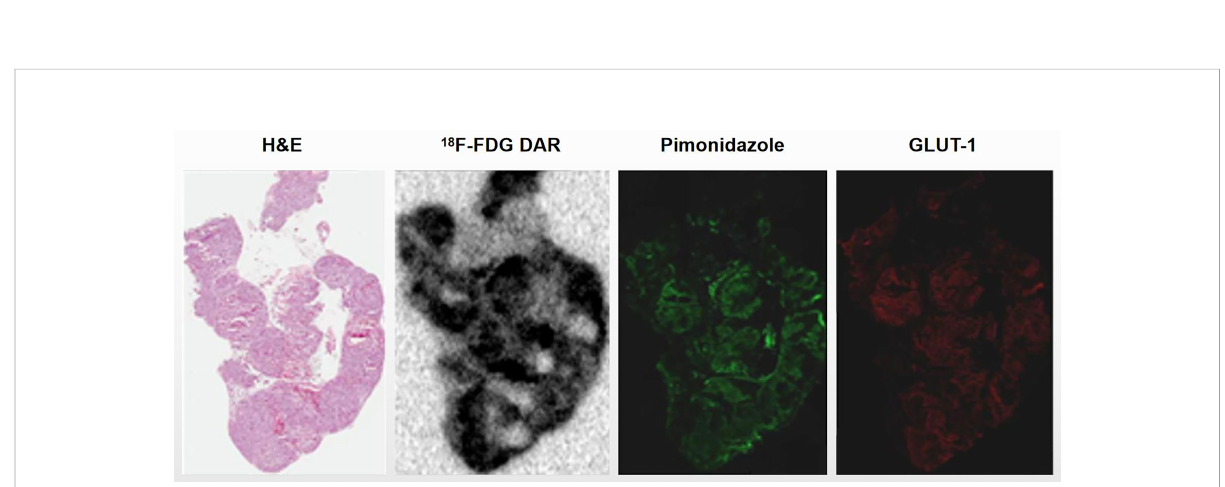
FIGURE 2 Ascites tumors showed high 18 F-FDG accumulation. Ascites tumor cells of HTB177 cell line. Tumor cells showed high uptake of 18 F-FDG by DAR, suggesting that their glucose metabolism activity was increased; Meanwhile, hypoxia markers pimonidazole and GLUT-1 were also highly expressed.